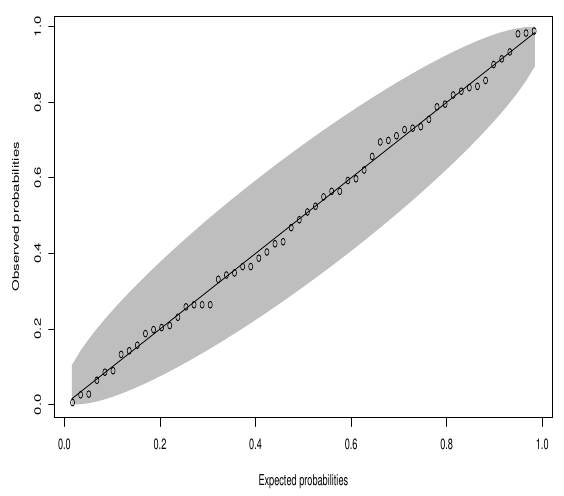
Figure 9. PP plot of the carbon dioxide data